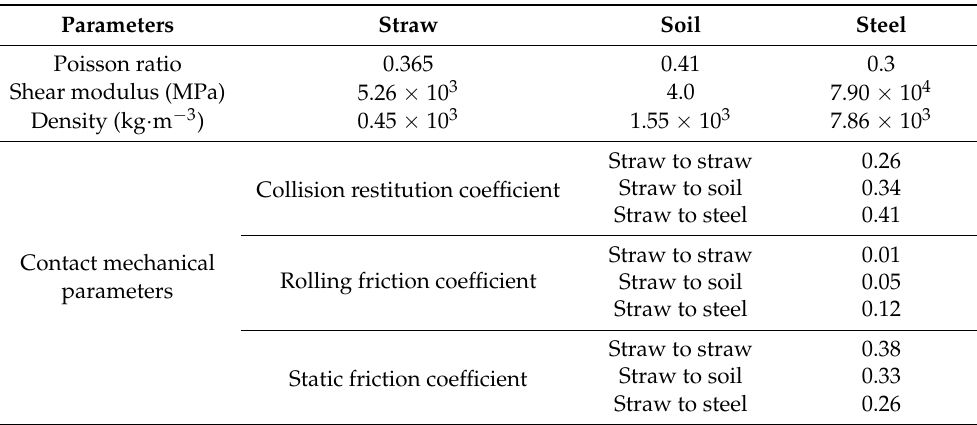
Table 1. Contact mechanical property parameters of the simulation